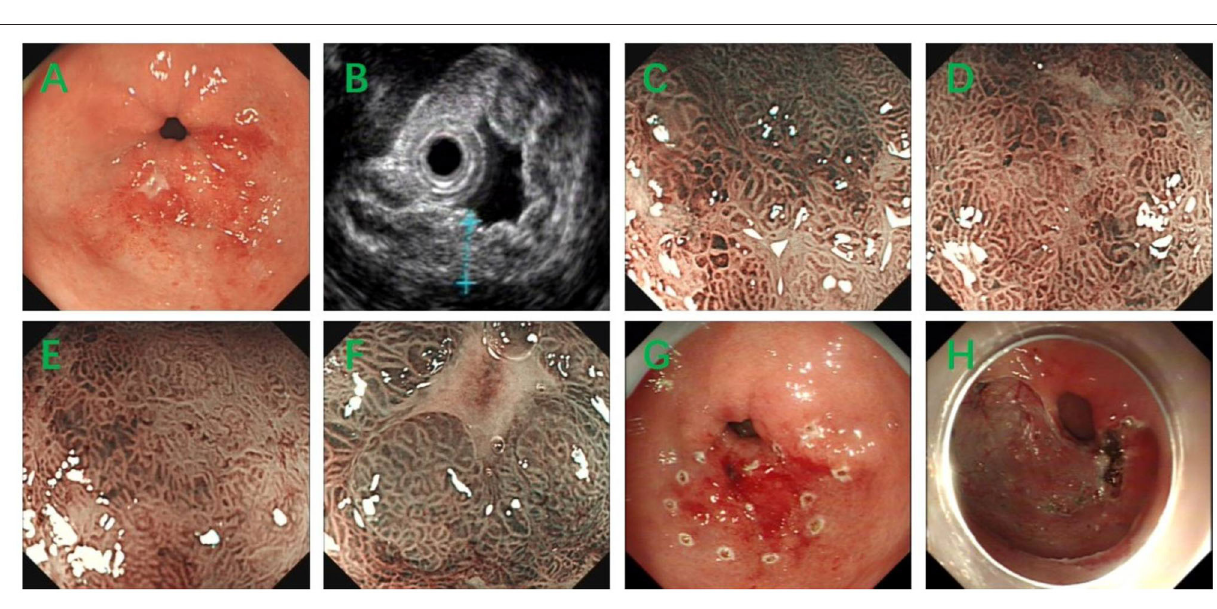
CD5, CD10, CD43, Bcl-6, SOX11, and cyclin D1 ( Figures 3A–D ). The Ki-67 index was